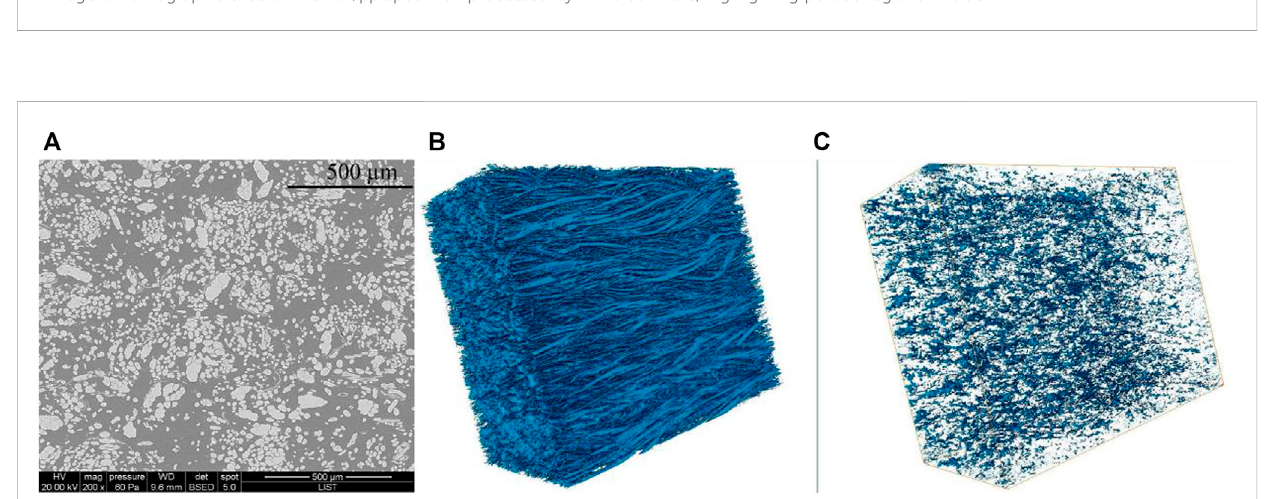
FIGURE 6 Fully consolidated ten-layer fl ax/pp composite: (A) cross-sectional morphology of consolidated image, (B) 3D image of fi bers from micro-CT, (C) 3D image of porosities from micro-CT with the following operating conditions: voltage: 70 kV; current: 160 μ A, isotropic voxel size: 6 × 6 × 6 μ m, scan time: 90